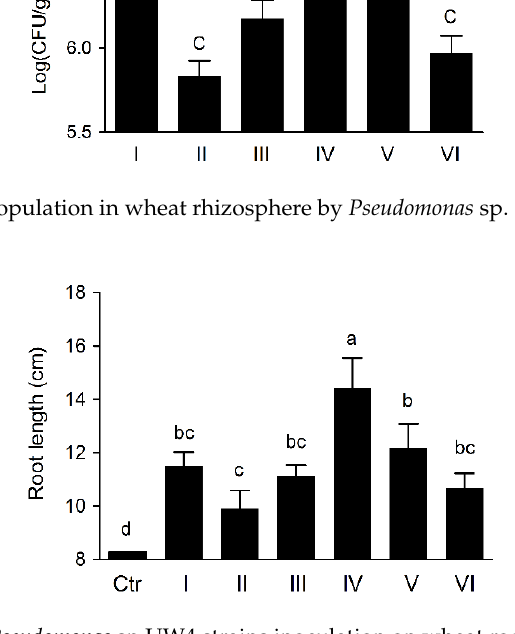
Figure 6. The e ff ects of Pseudomonas sp.UW4 strains inoculation on wheat root length in Pot trial. Ctr, Figure 6. The effects of Pseudomonas sp.UW4 strains inoculation on wheat root length in Pot trial. Ctr, control with non-inoculation. Other notes: Same as Figure control with non-inoculation. Other notes: Same as Figure 1. Figure 6. The effects of Pseudomonas sp.UW4 strains inoculation on wheat root length in Pot trial. Ctr, Figure 6. The effects of Pseudomonas sp.UW4 strains inoculation on wheat root length in Pot trial. Ctr, control with non-inoculation. Other notes: Same as Figure 1. control with non-inoculation. Other notes: Same as Figure 1.